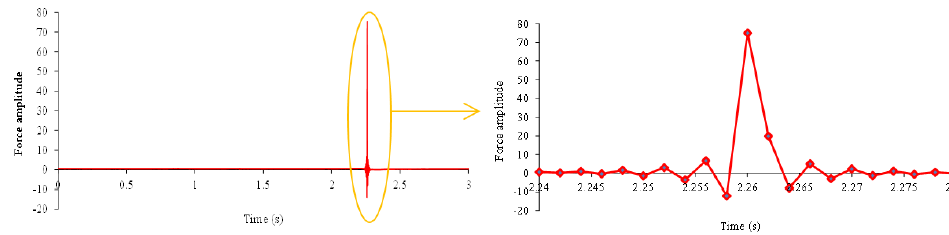
Figure 15. Hammer impact force.